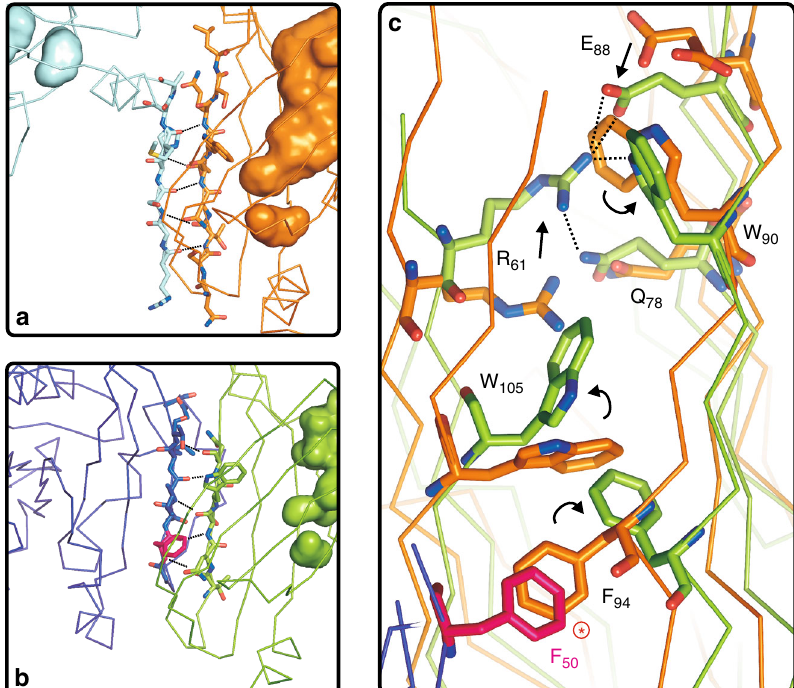
Fig. 3 Comparison of open and closed conformation of PrBP/ δ . a Apo-PrBP/ δ in “ open ” conformation. Apo-PrBP/ δ in open conformation is shown as ribbon representation with a cavity-surface (cyan/orange). A β -sheet extension is formed due to β -strand 6 interaction based on the crystallographic interface of apo-PrBP/ δ (orange) with N-terminus of the symmetry related apo-PrBP/ δ molecule (cyan). b PrBP/ δ in “ closed ” conformation. In the crystal structure complex of PrBP/ δ with its displacement factor Arl2 a very similar β -sheet extension is formed in which the β -strand 6 of PrBP/ δ (green) interacts with β 2 strand of Arl2 (purple). Phe50 of Arl2 (highlighted in pink) ( c ) seems to induce a rotameric shift of Phe94 in PrBP/ δ . For both apo-PrBP/ δ ( “ open ” conformation) and Arl2-bound PrBP/ δ ( “ closed ” conformation) this extension of the β -sheet with β 6 is observed. c Superposition of the apo-PrBP/ δ in “ open ” (orange) and PrBP/ δ -Arl2-bound in closed (green) conformation. Closure of the PrBP/ δ cavity is apparently induced by the Phe50 of Arl2 that might induce a cascade of side chain shifts of several residues such as Phe94, Trp105 and Arg61. These shifts allow formation of a new hydrogen bonding network including the residues Arg61, Gln78, Glu88, and Trp90 in the “ close ” conformation that are additionally responsible for the size reduction of the cavity. In contrast the distance between Arg61 and Glu88 is ~10 Å in the “ open ” conformation of apo-PrBP/